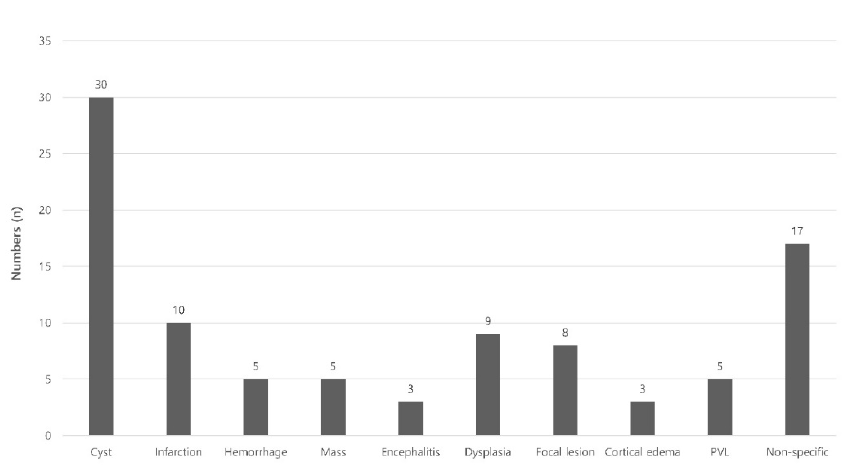
Figure 3. Classification of neuroimaging abnormalities. PVL, periventricular